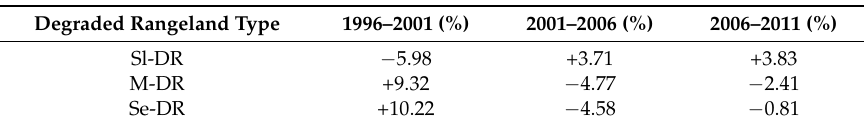
Table 4. Annual change rate of degraded rangeland from 1996 to 2011 (positive values mean an increase, negative values represent a decrease).